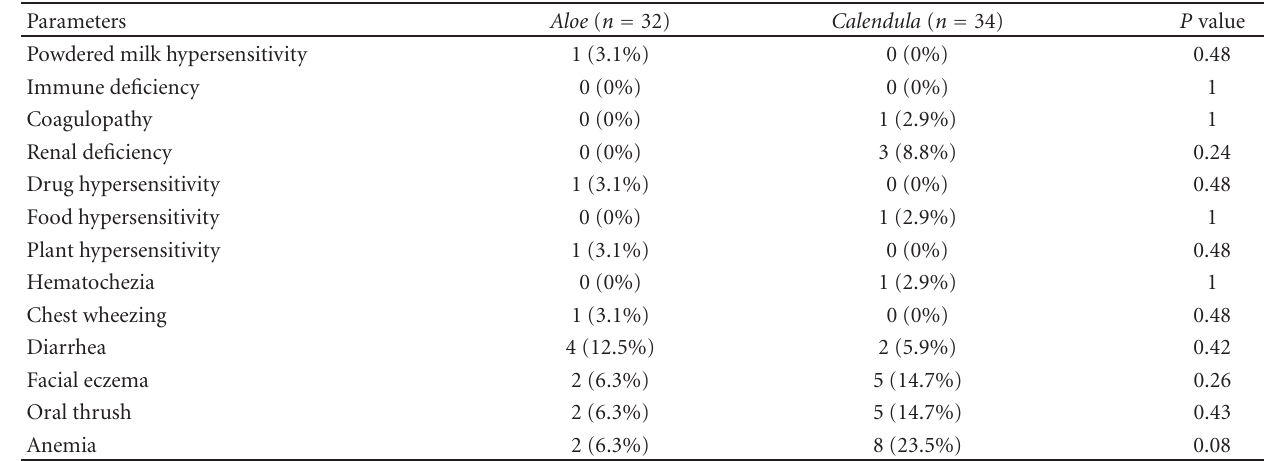
Table 2: Past medical history of study